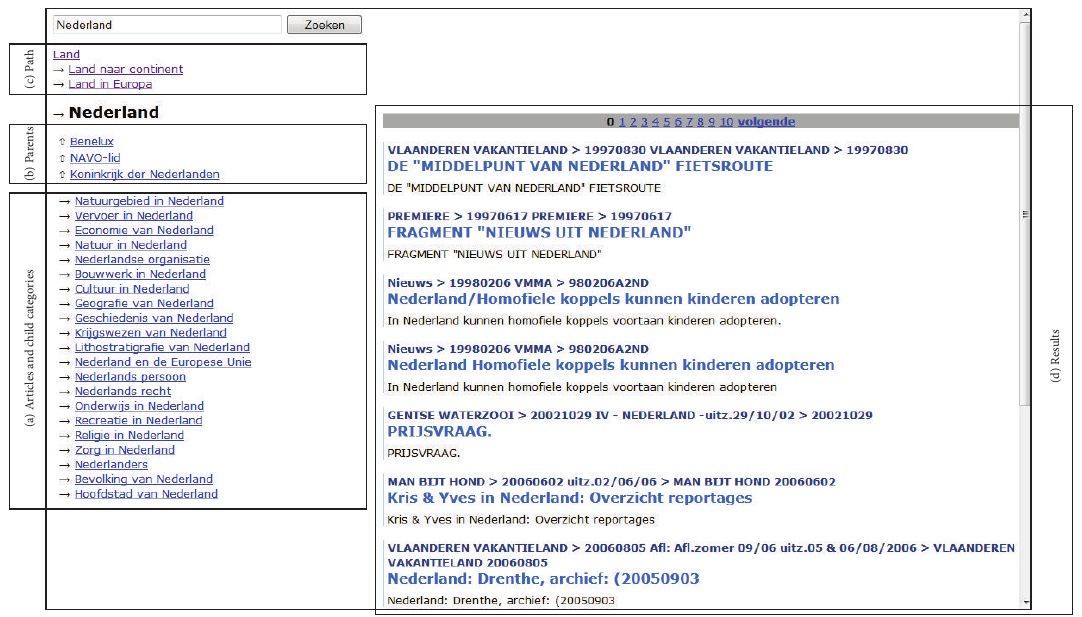
Figure 5: The user interface when the user entered “Land” (country) and subsequently clicked “Land naar continent” (country by continent), “LandinEuropa”(CountryinEurope),and“Nederland”(theNetherlands).Thefollowingareasoftheuserinterfacearemarked(a)thearticles and child categories of the category “Nederland,” (b) the parent categories of “Nederland,” other than “Land in Europa,” the one that is listed in (c), (c) the traversed categories, only when a link in (a) is followed, and (d) results for searching the database with the query “Nederland,” as in the traditional search